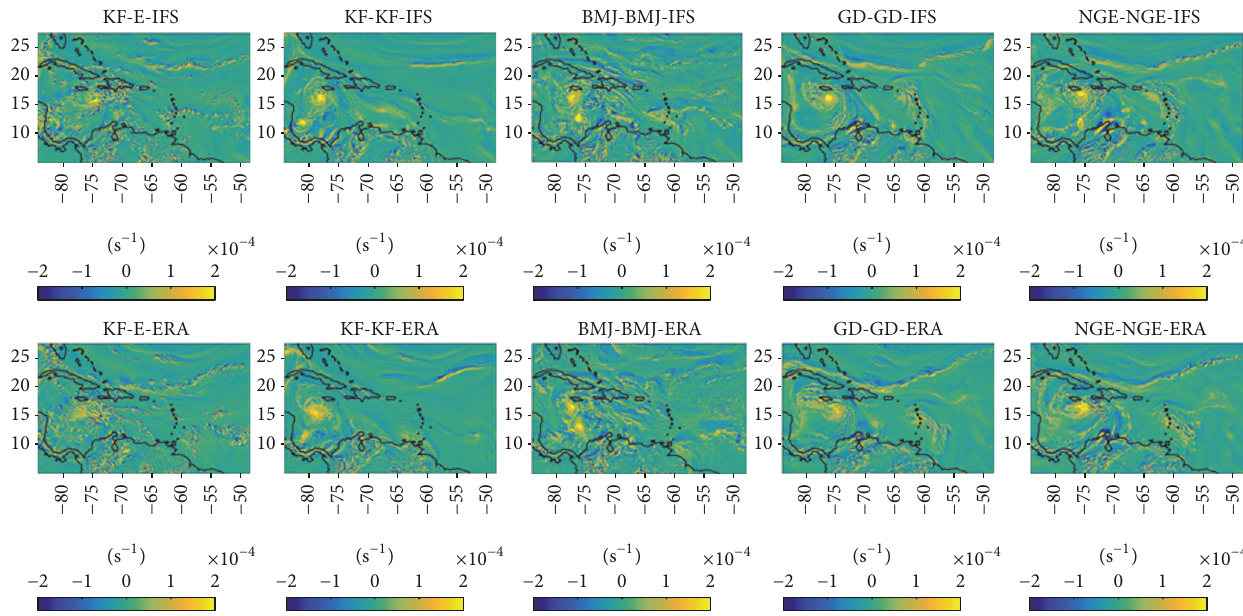
Figure 3: Vertical vorticity horizontal cross section at 𝑧 = 2500 m for the different WRF experiments at 00UTC on 4 November 2010.